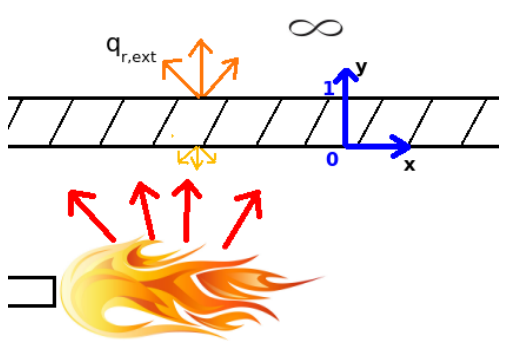
Figure 2. Schematic of a confined turbulent flame with radiative heat loss to the environment via the